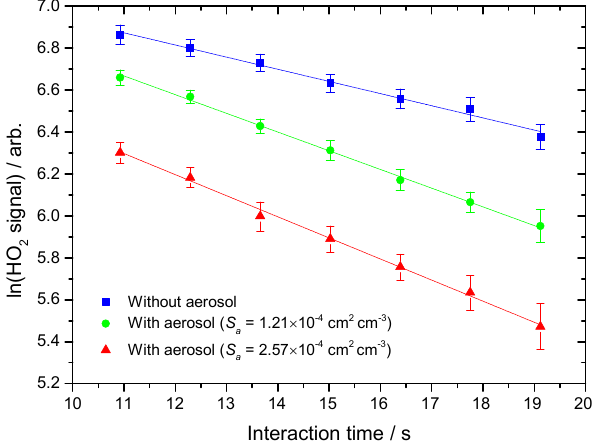
Figure 2. Measured HO 2 signal at different interaction times, in the presence of TiO 2 particles (surface area density: 1.21 × 10 − 4 and 2.57 × 10 − 4 cm 2 cm − 3 , green circles and red triangles respectively) and in their absence (blue squares). The RH in the aerosol flow tube was 11%, the lowest used in this study. The lines represent linear least-squares fits to the data, yielding k obs = 0.079 ± 0.005 and k obs = 0.093 ± 0.003s − 1 (aerosols present, green circles and red triangles respectively) and 0.049 ± 0.003s − 1 (no aerosols, k wall